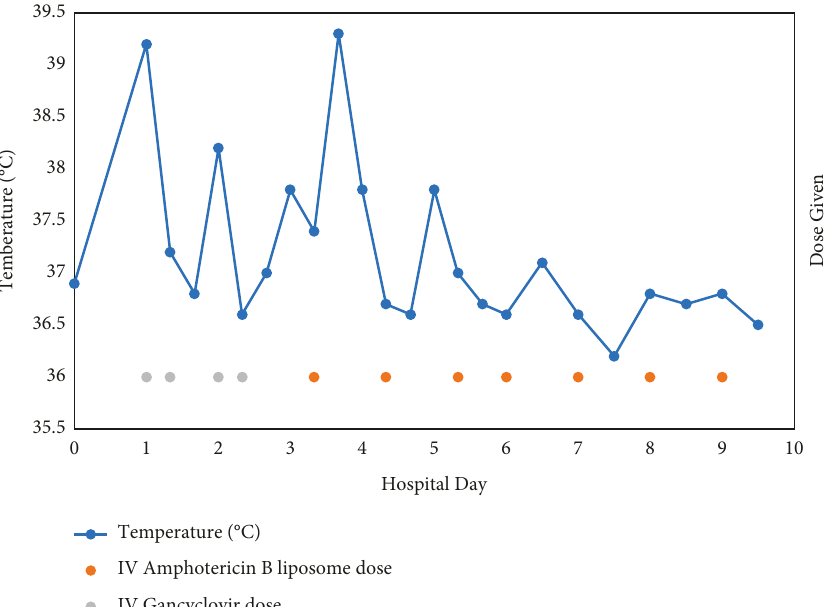
Figure 2: Temperature response to the initiation of antifungal therapy. Graph of the patient’s temperature throughout until her final consultation to the hospital and diagnosis of disseminated histoplasmosis. This graph shows the patient's temperature throughout her final hospitalization. Each dose of IV ganciclovir and IV amphotericin are indicated by gray and orange dots,